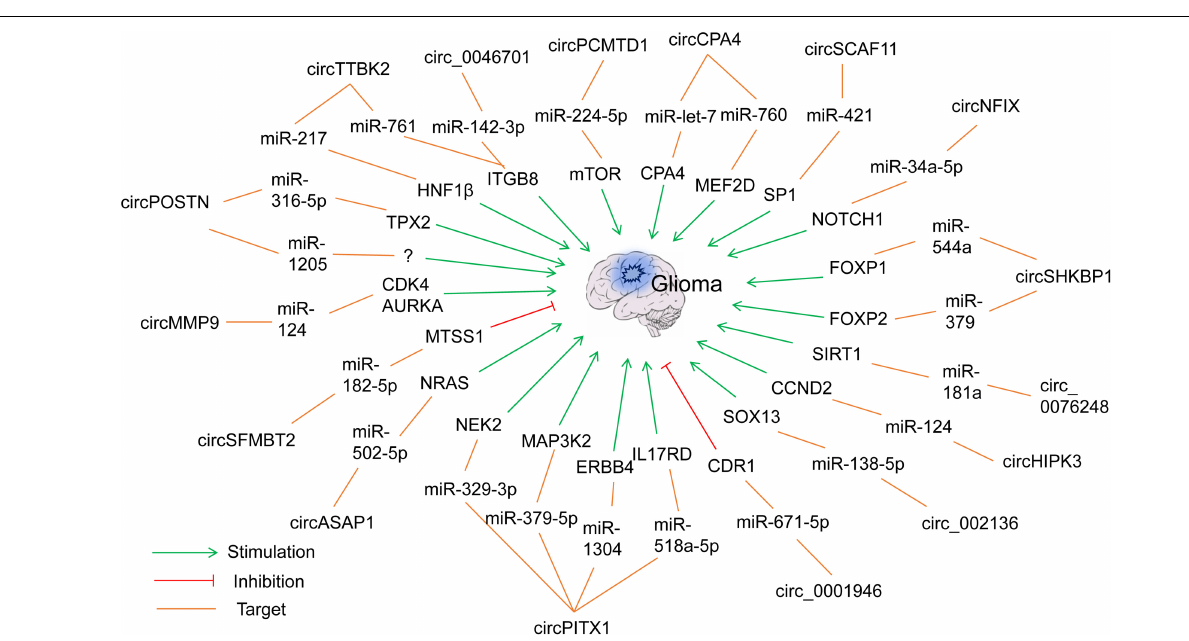
FIGURE 3 | Representative circRNA-mediated ceRNETs in